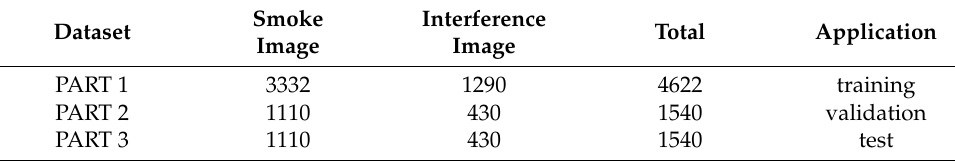
Table 2. Forest fire smoke